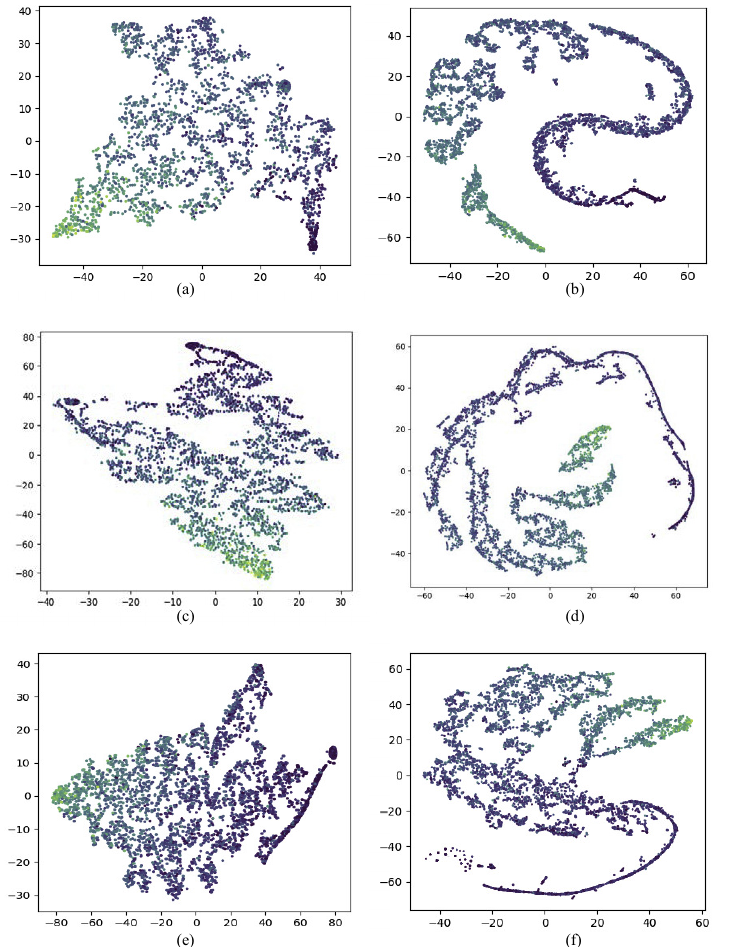
Figure 8. Visualization of learned representation: ( a , c , e ) show the cascade graph representations with observation time window set to be 1 h, 2 h, 3 h separately. ( b , d , f ) show the temporal representations with observation time window set to be 1 h, 2 h, 3 h